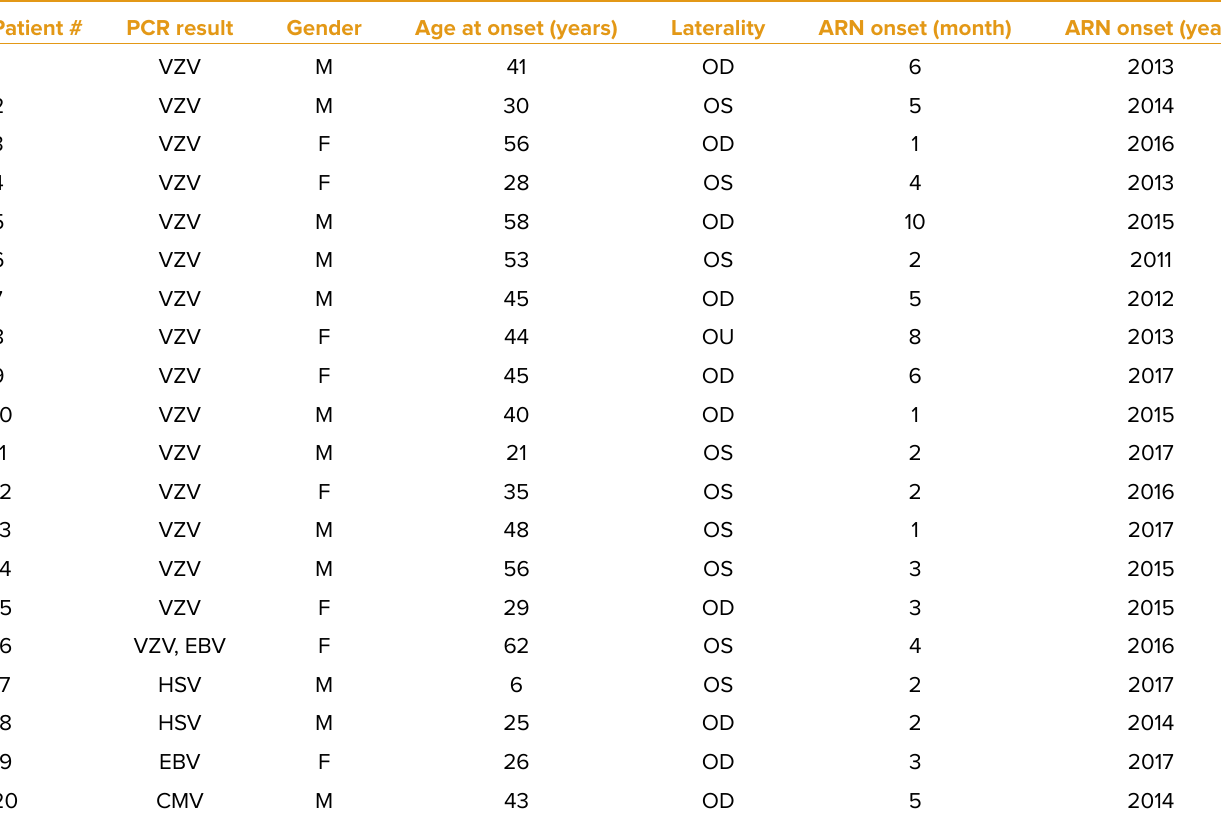
Table 1. Demographics, causative viral agent(s), and date of disease onset in ARN cases Patient